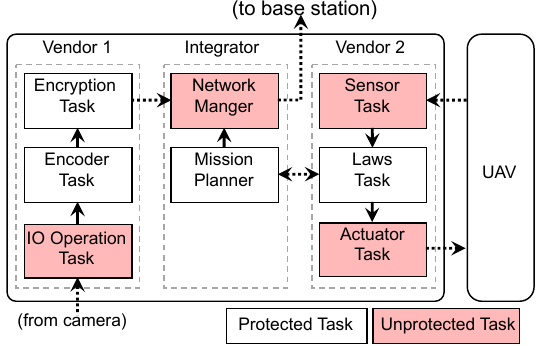
Figure 2. A high-level design of a UAV that exemplifies the multi-vendor development model. In this demonstrative system, three vendors are involved in building the ECU system: Vendor 1 comprises tasks that process image data from a surveillance camera attached to the ECU; Vendor 2 is in charge of flight control tasks interacting with the UAV; and Integrator handles communication between the system and a base